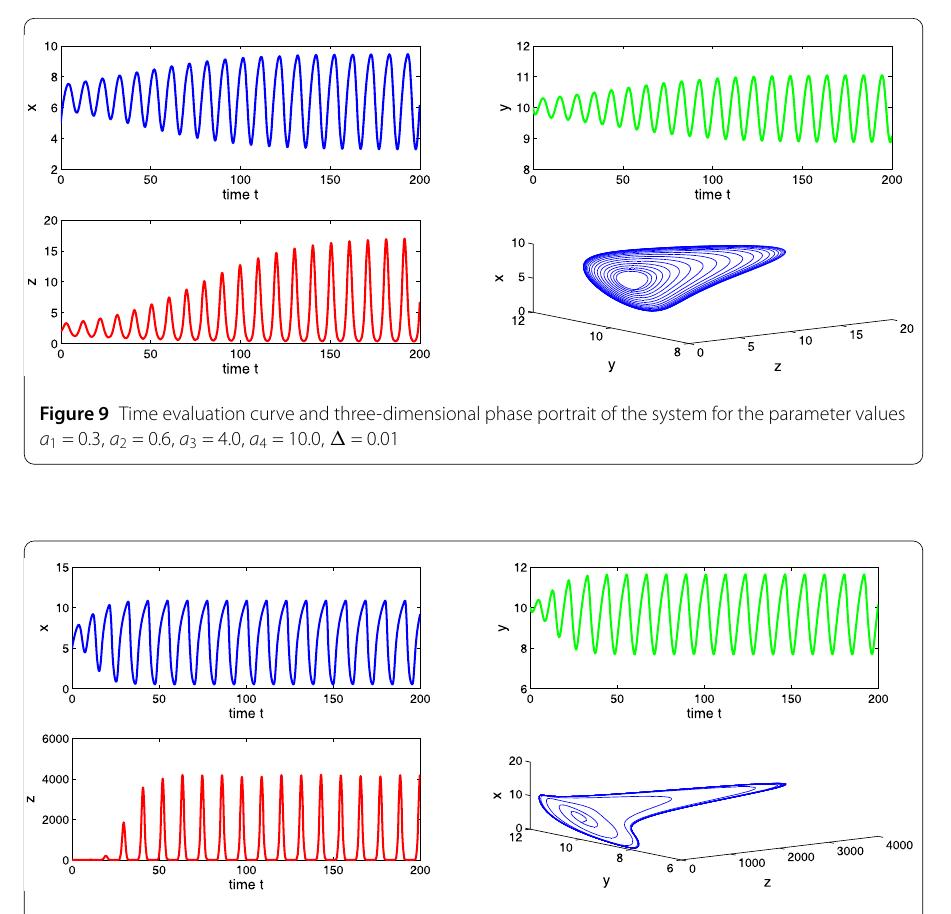
Figure 10 Time evaluation curve and three-dimensional phase portrait of the system for the parameter values